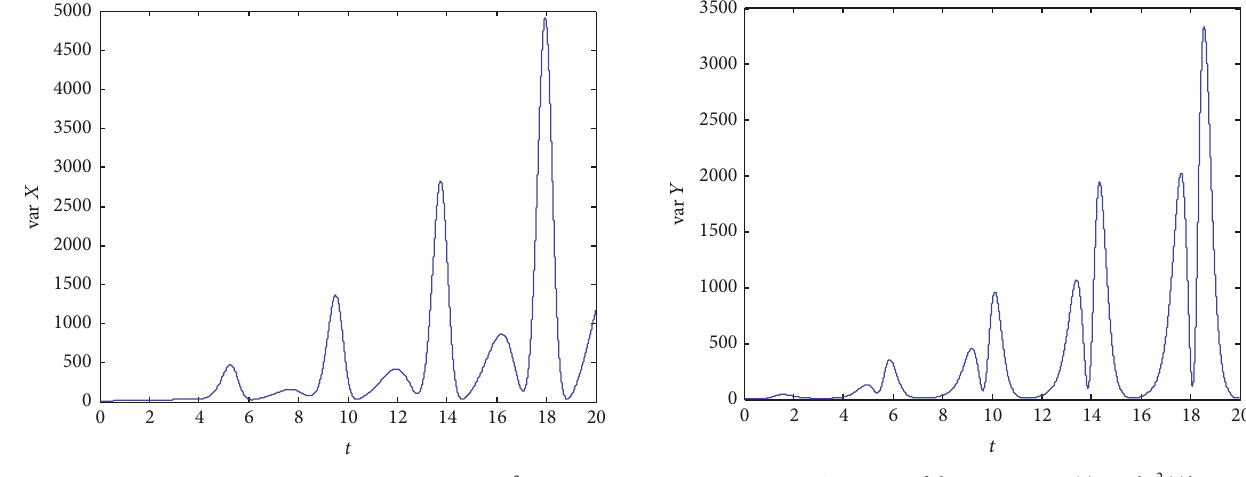
Figure 4: Trajectory of the variance 𝑞 11 (𝑡) = E {𝑋 2 (𝑡)} . Figure 5: Trajectory of the variance 𝑞 22 (𝑡) = E {𝑌